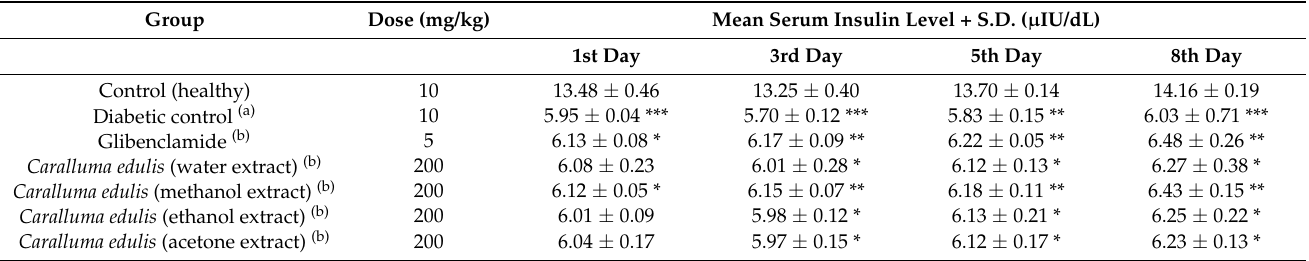
Table 9. Subacute effect of Caralluma edulis extracts on serum insulin levels in alloxan-induced diabetic